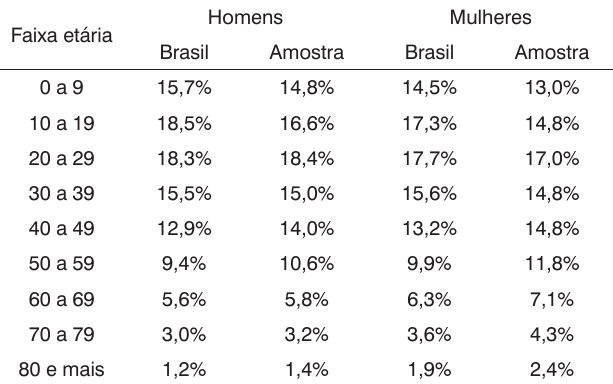
Tabela 1. Proporção da população do Brasil (2010) e da amostra, por idade e